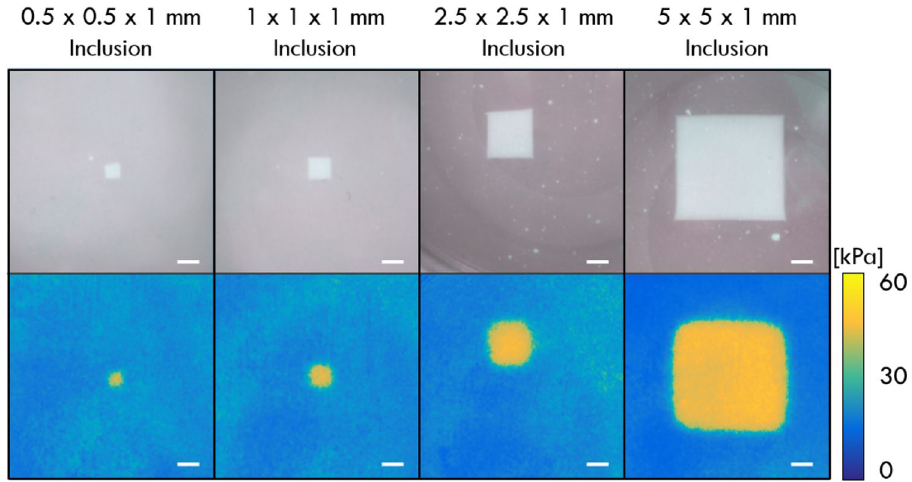
Figure 4. Photographs and optical palpograms acquired at 50% preloaded strain for four different-sized inclusion phantoms. Photographs are provided for validation purposes only to show the relative positions of the inclusions and were taken without the micro-porous layer. Scale bars: 1